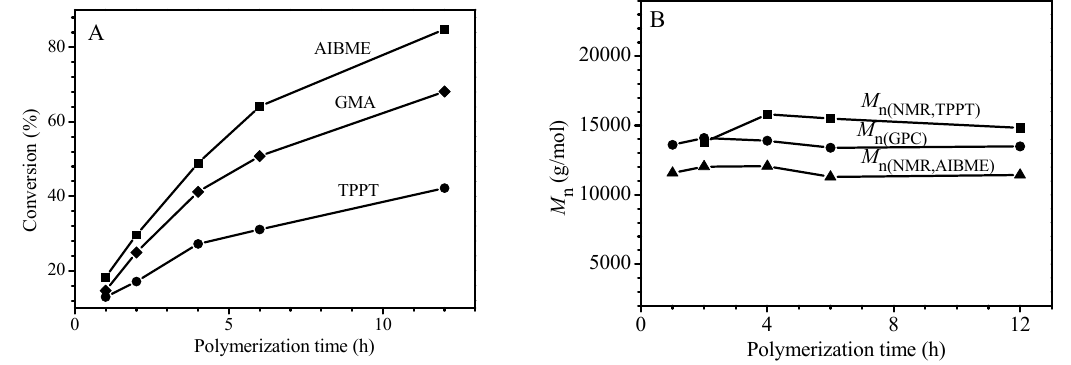
Figure 3. The relationship of the GMA, AIBME and TPPT conversions with polymerization time ( A ) and the dependence of molecular weights ( M n s) measured by NMR method and gel permeation chromatography (GPC) method ( B ) for the polymerization of GMA with feed molar ratio of GMA/TPPT/AIBME = 100/2/1 at 70 °C in anisole (50 wt %).